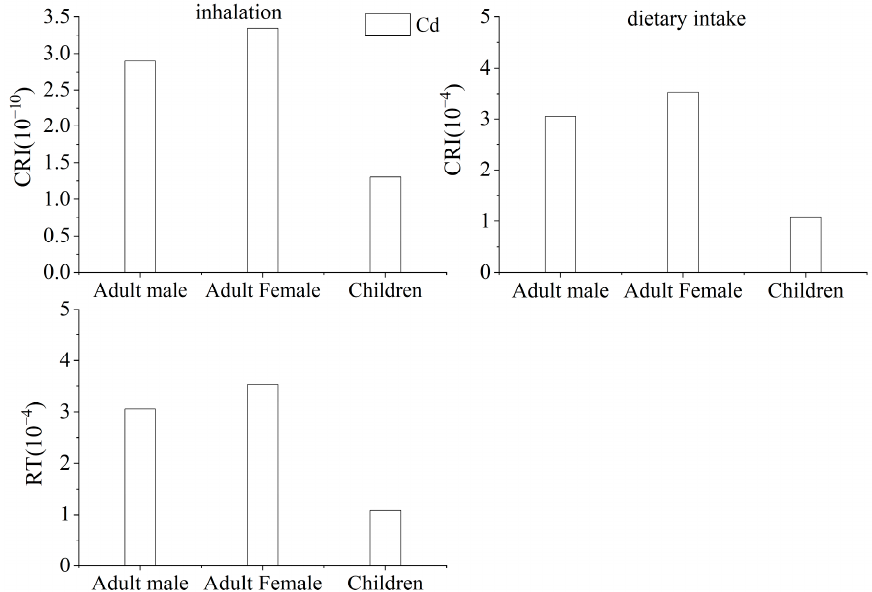
Figure 5. Carcinogenic risks of the heavy metals through two exposure pathways.